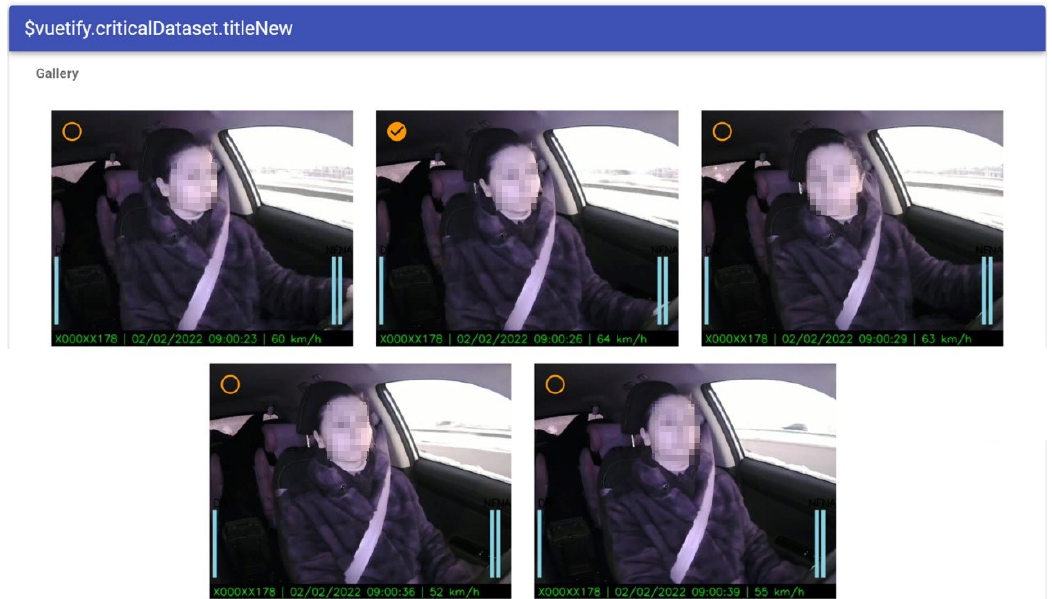
Figure 5. Screenshot example: choosing images for dataset retraining.